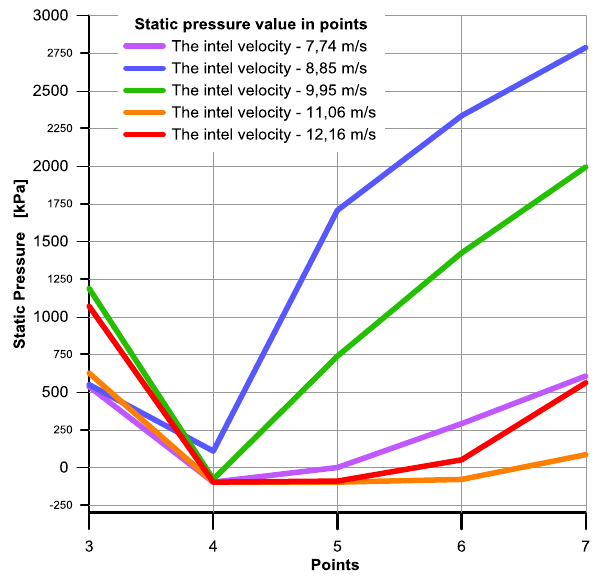
Fig. 10. The results of pressure in the tunnel for points 3 to 7